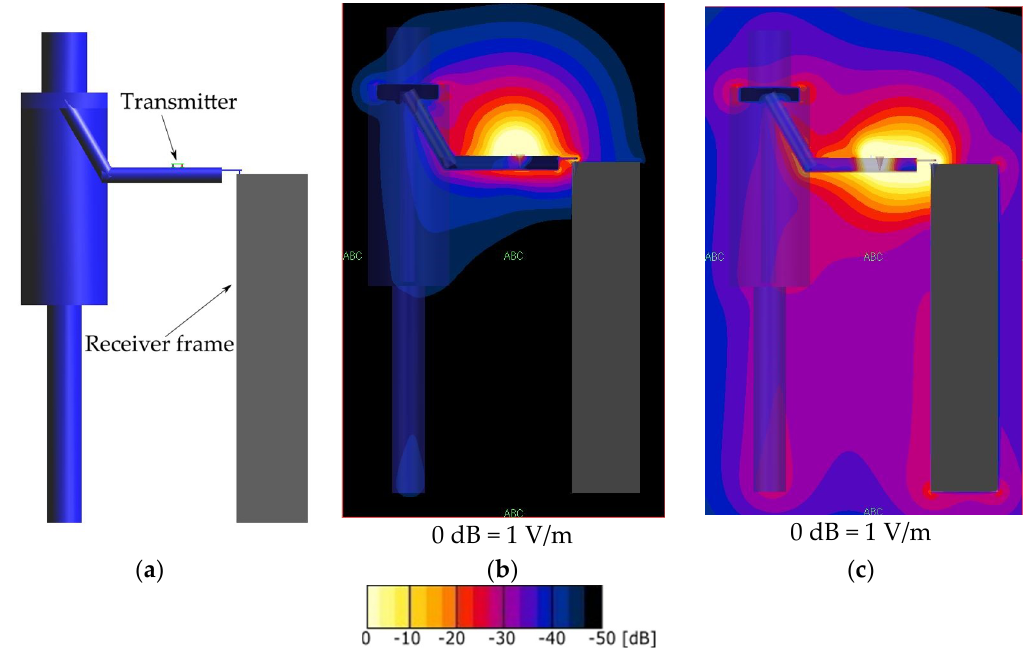
Figure 4. Electric field distribution in a vertical cross-section containing the transmitter, the receiver, and the human arm viewed from right side of the model. ( a ) Configuration of the simulation model. ( b ) Electric field distribution for the one-electrode transmitter. ( c ) Electric field distribution for the two-electrode transmitter.